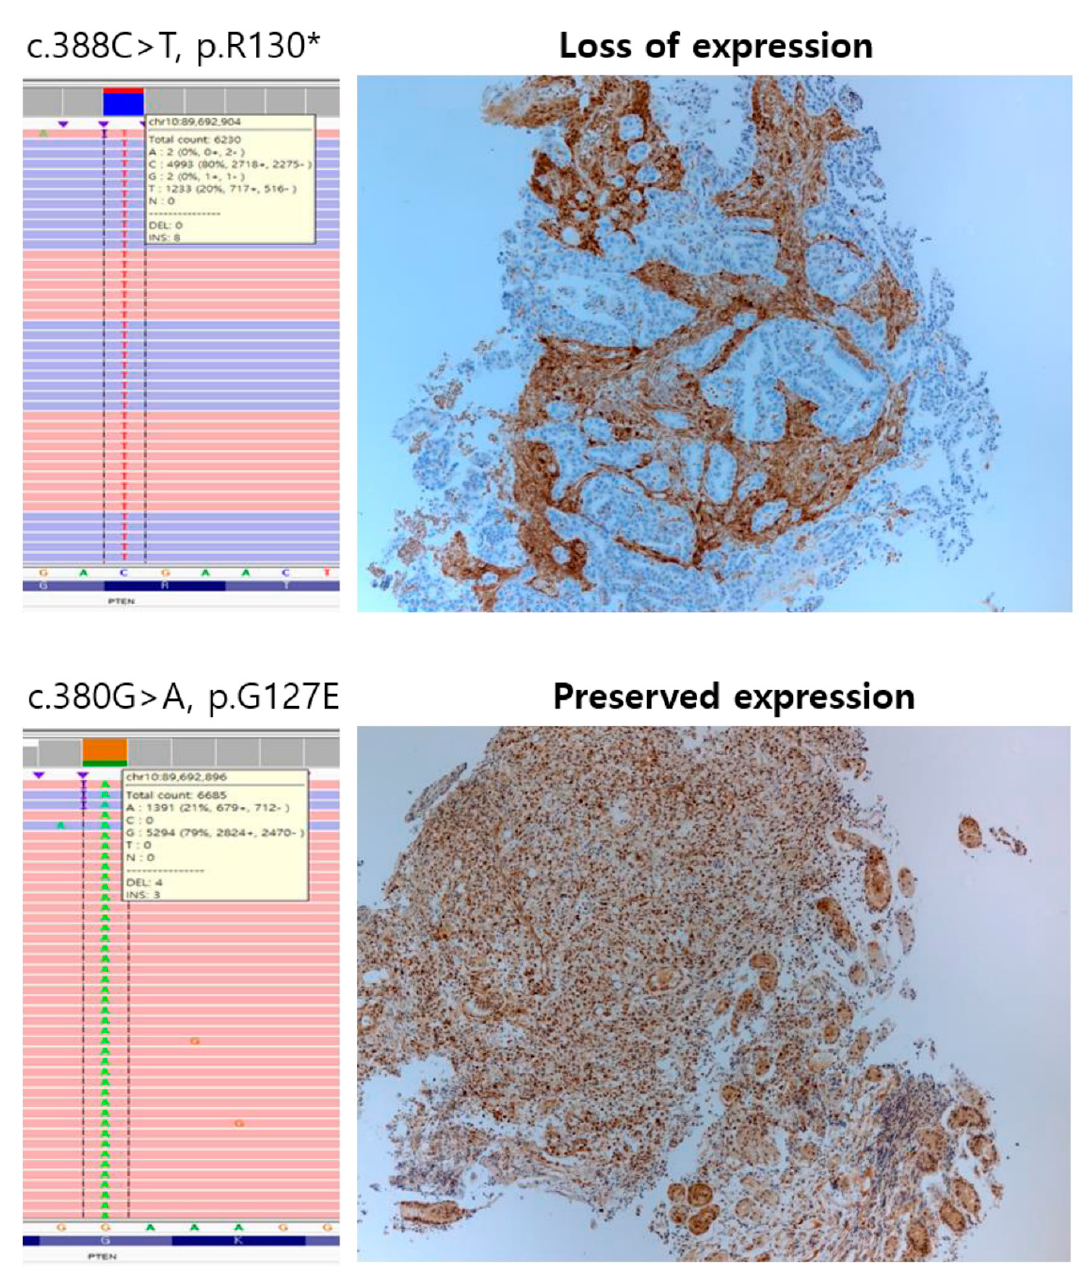
Figure 1. Representative cases of Phosphatase and Tensin Homolog (PTEN) immunohistochemistry and PTEN mutation confirmed by Integrative Genomics Viewer. Table 2. Comparison of clinicopathologic characteristics between phosphatase and tensin homolog